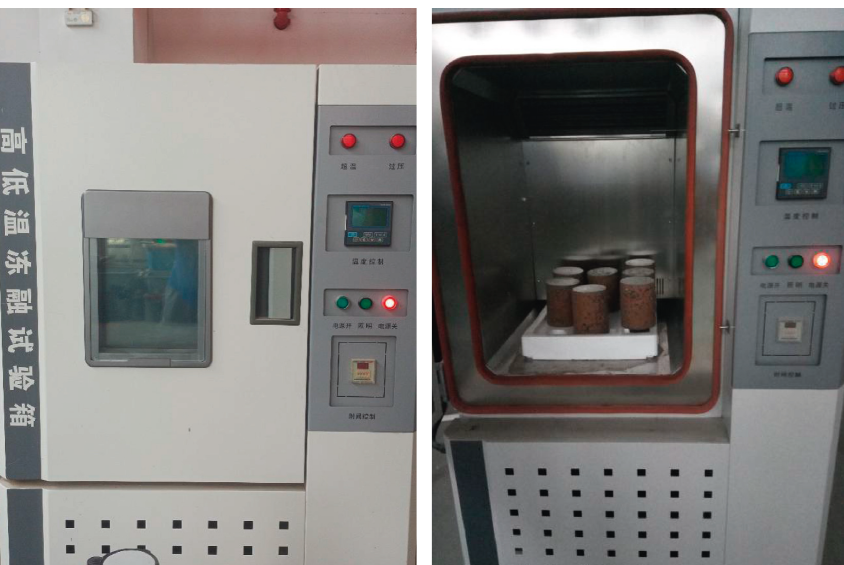
Figure 12: Freeze-thaw cycle test.